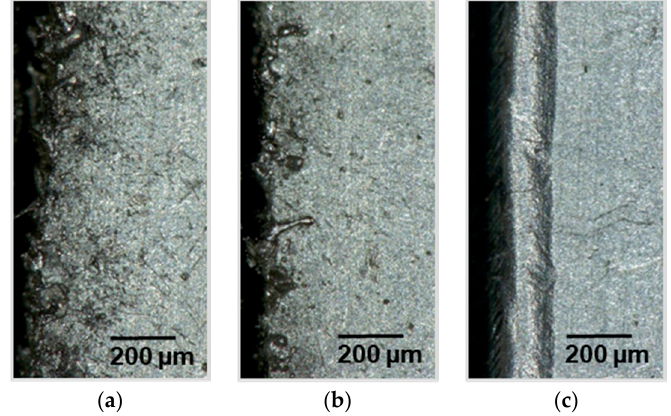
Figure 10. Light microscope sections of a laser cut lithium sheet: 72.8 W, 100 mm/s, 240 ns; ( a ) 70 kHz, PO 98.41%; ( b ) 200 kHz, PO 99.44%; ( c ) 350 kHz, PO